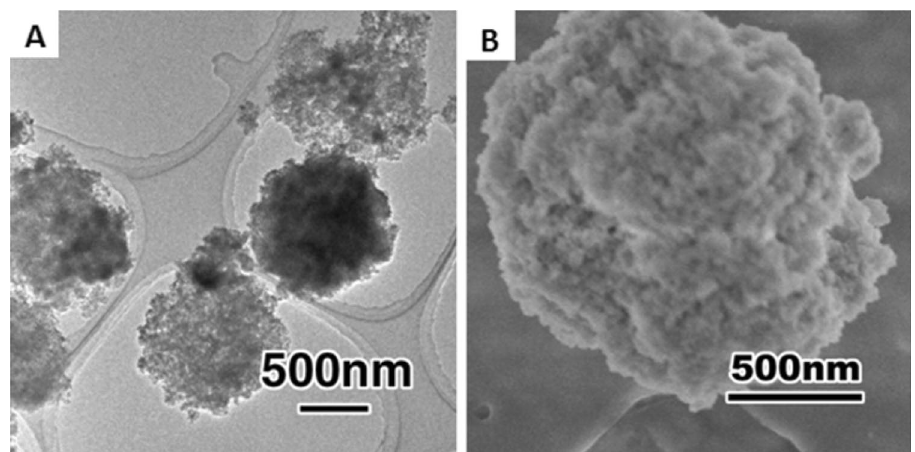
Fig. 6 TEM and SEM images of spray-dried pure ZrO